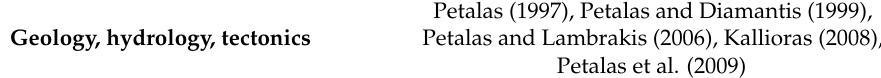
Table 1. Data sources for the appropriate information for the specific